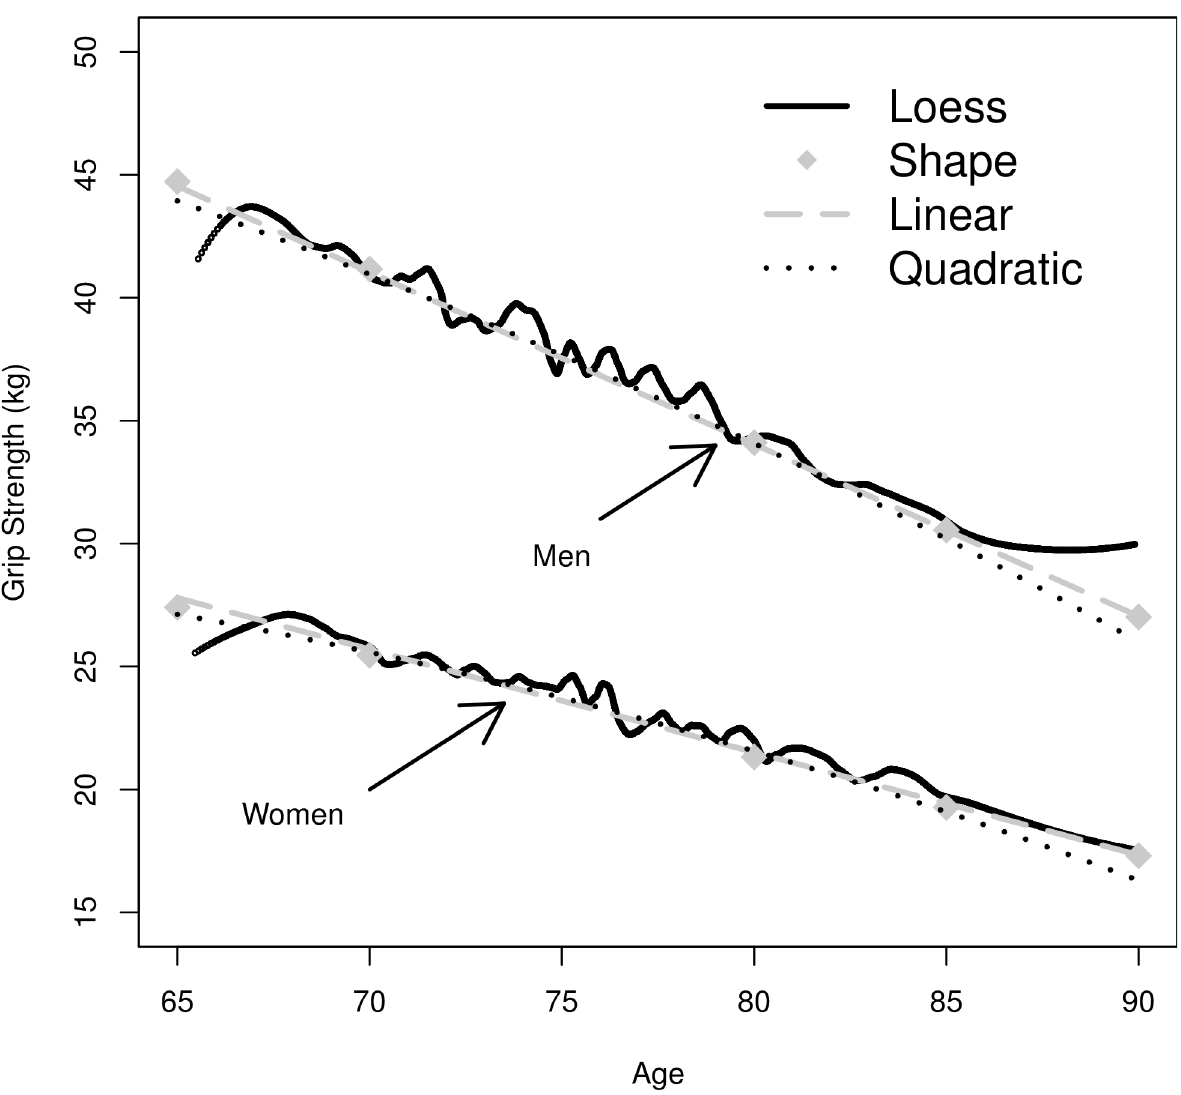
Fig 1. Model fit of three specifications of the slope in latent growth model of grip strength for men and women. Note : Figure shows the predictions of three specifications compared to the observed trajectory of grip strength estimated by locally weighted scatterplot smoothing (LOESS).